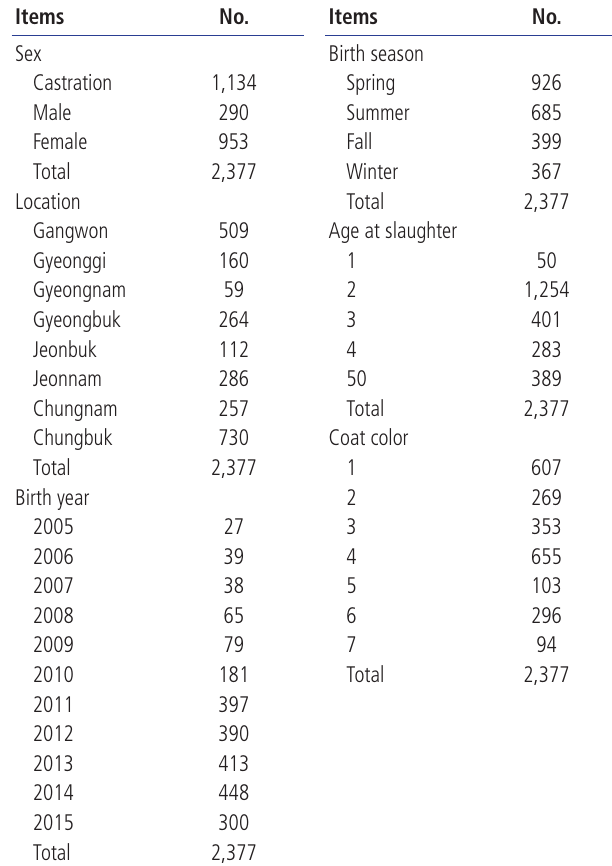
Table 1. Number of animals by sex, location, birth year, birth season, age at slaughter and coat